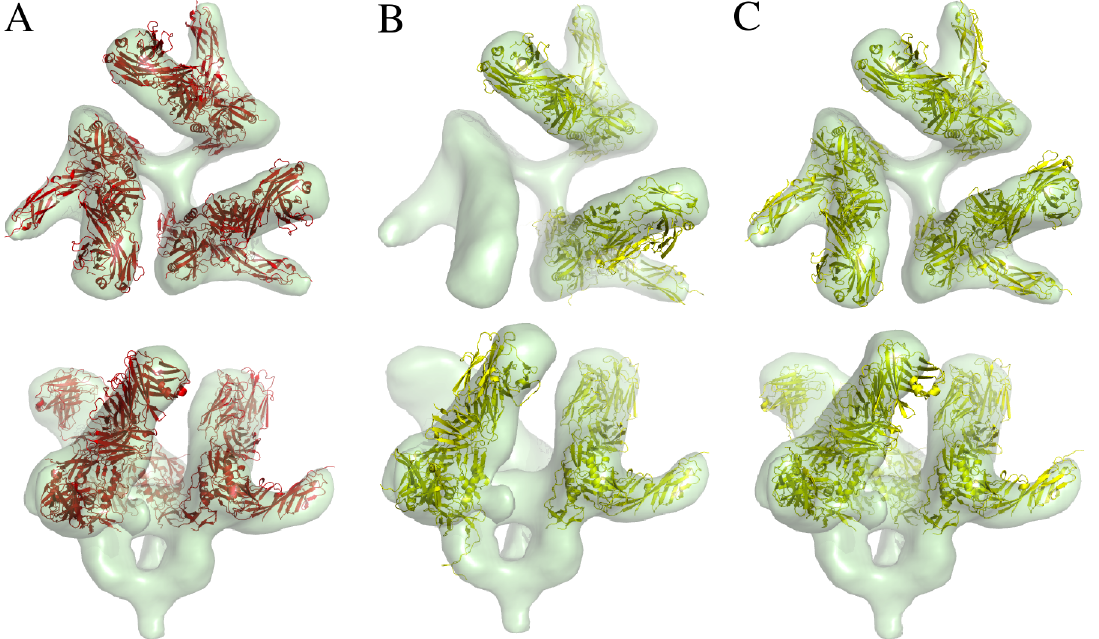
Fig 8. Comparison of PF 2 fit with other software in subunit-assembly fitting. Fitting the PDB molecule P (1GC1) to the EM map M of SIV 20 Å (EMD5020), using the GCCS. Two different views of the molecules are given: (A) Results from PF 2 fit . The ETR is 0.03. (B) Results from colores with default options. The ETR is 0.1. (C) Results from ADP_EM with L = 25. The ETR is